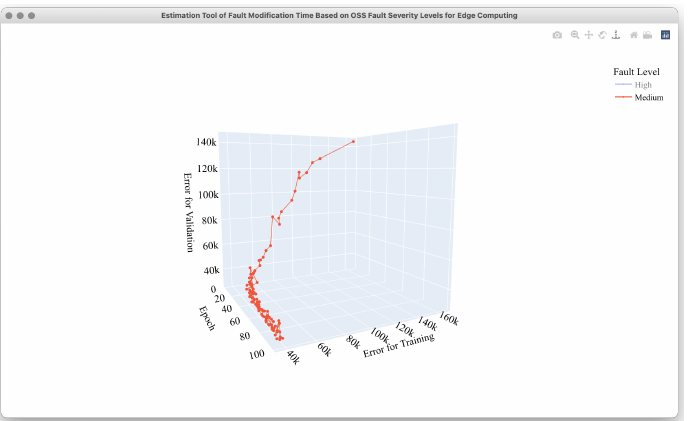
Figure 12. The estimated error between validation and training in case of medium-level 30% testing data.